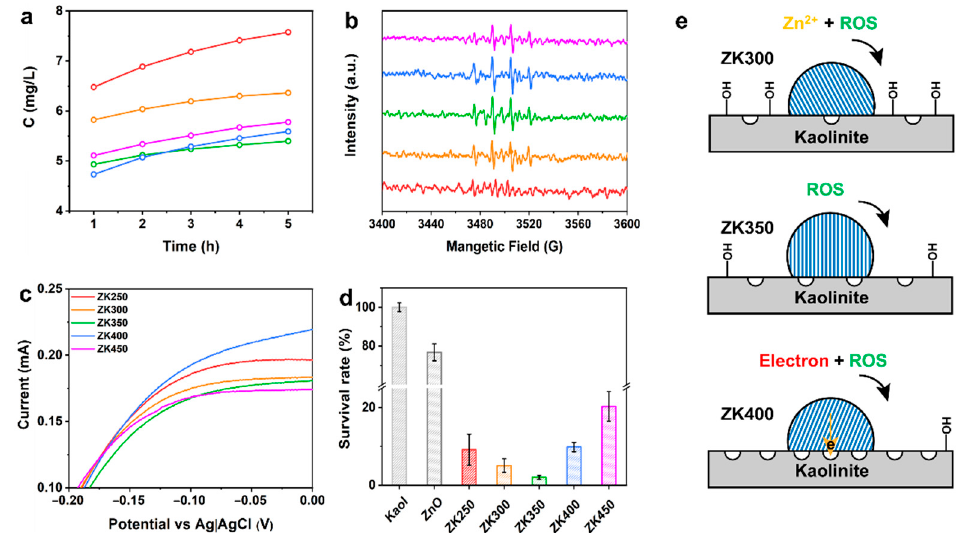
Figure 4. Evaluation of antibacterial activity. ( a ) Zinc ions released from samples at 1 h, 2 h, 3 h, 4 h, and 5 h; ( b ) Detection of •OH after prepared samples incubated in solution at 4 h; ( c ) I–V curves of a complex of bacteria and samples after 4 h; ( d ) Survival rate of samples; ( e ) Illustration of antibacterial mechanism of different interface interactions.